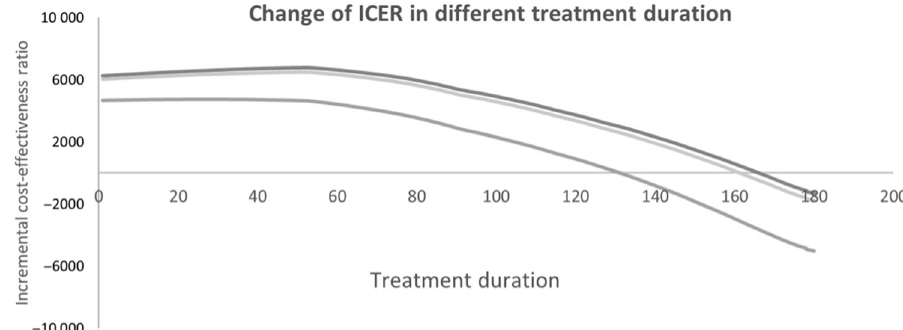
Fig. 3 Change of ICER in different treatment duration. Note: the x -axis was based on logarithm scale for better convenience to see. Light gray line: portable spirometer vs. no screening (usual care); median gray line: questionnaire vs. no screening (usual care); and dark gray line: portable spirometer vs. questionnaire.